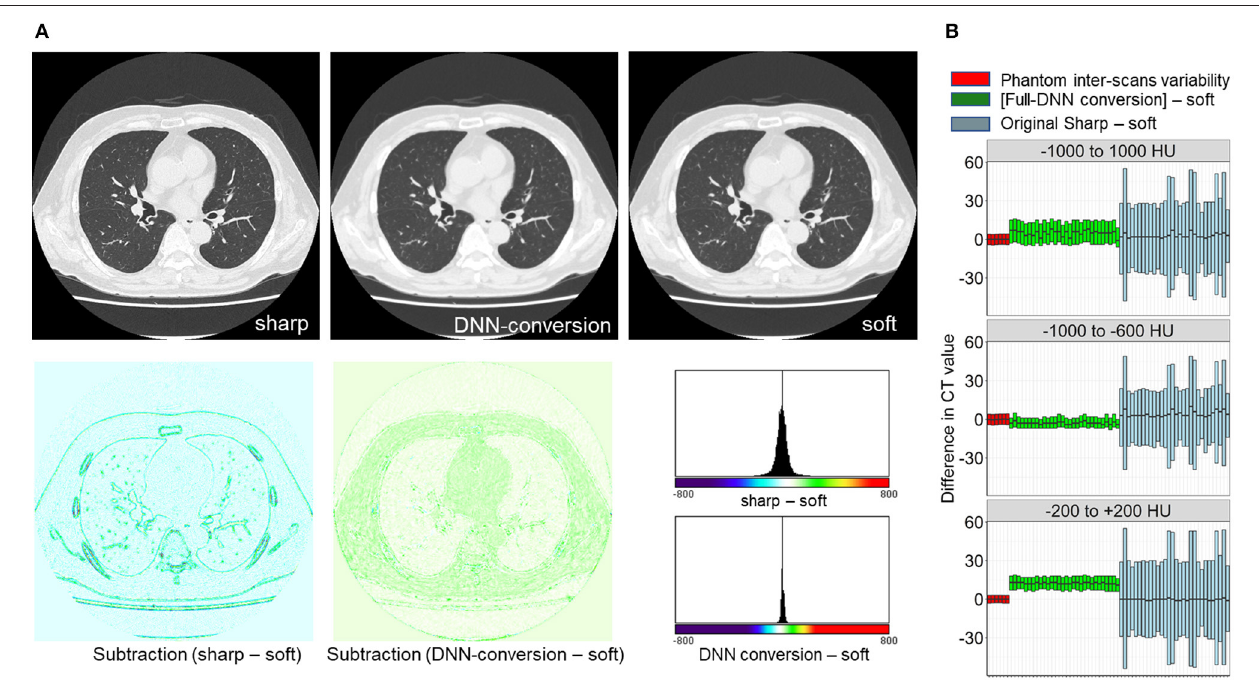
FIGURE 4 | Differences in CT values between deep learning-based (sharp to soft) kernel-converted images and ground-truth soft kernel images. (A) Sharp kernel images in the validation dataset ( n = 30) were converted using a deep neural network without truncating input images (FULL-DNN conversion). The difference in CT values between converted and soft kernel images was smaller than the differences in CT values between the original sharp and soft kernel images. (B) These differences in CT values were assessed in regions with CT values between − 1,000 and 1,000 HU (broad range), those between − 1,000 and − 600 HU, and those between − 200 and 200 HU. In regions with CT values between − 200 and 200 HU, the differences in CT values between converted and soft kernels were higher than differences between averaged phantom CT and each phantom